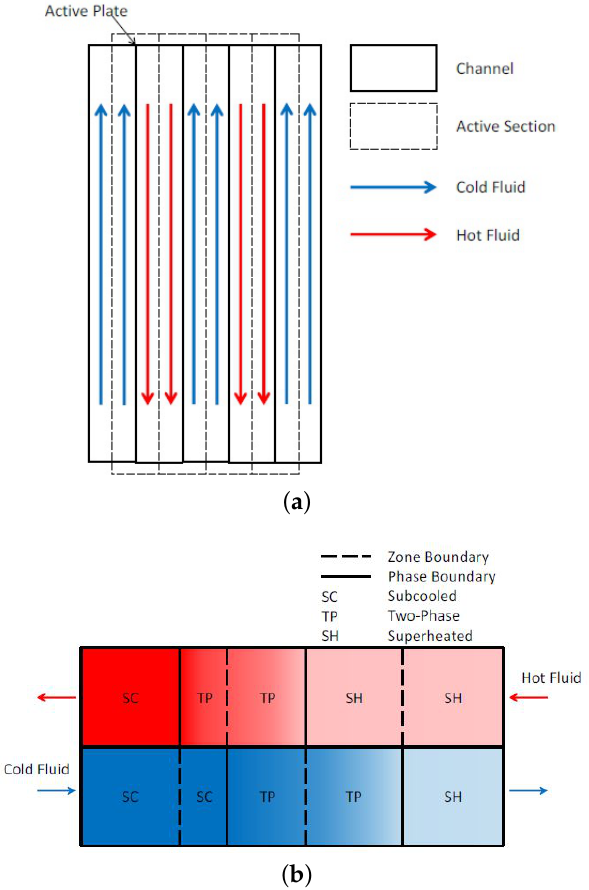
Figure 2. ( a ) Schematic diagram of the channels and active counterflow sections inside a plate heat exchanger. Six plates are shown with five channels and four active sections or plates; ( b ) The most general case of the counterflow moving boundary model, showing five zones. Each zone is defined by the phase boundary of one of the fluids. Adapted from